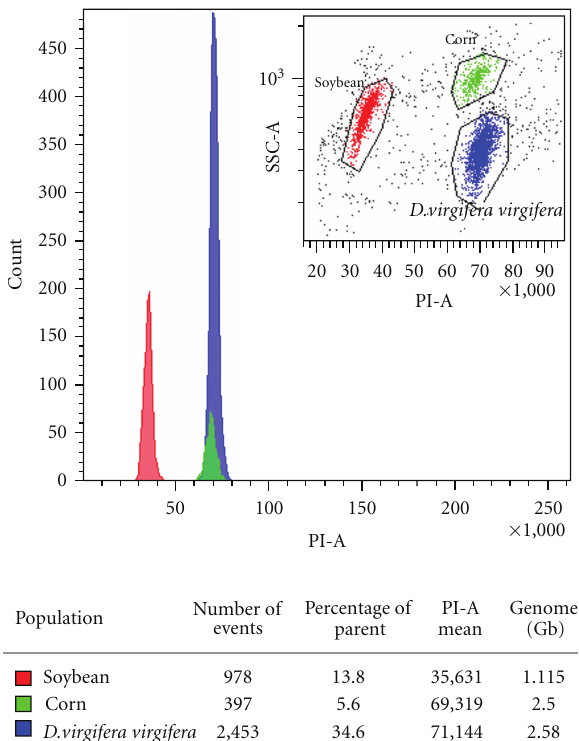
Figure 1: Flow cytometry estimate of the D . virgifera virgifera genome size compared to internal standards of Zea mays (inbred line B73; 2.500 Gb) and Glycine max (isoline Williams 83; 1.115